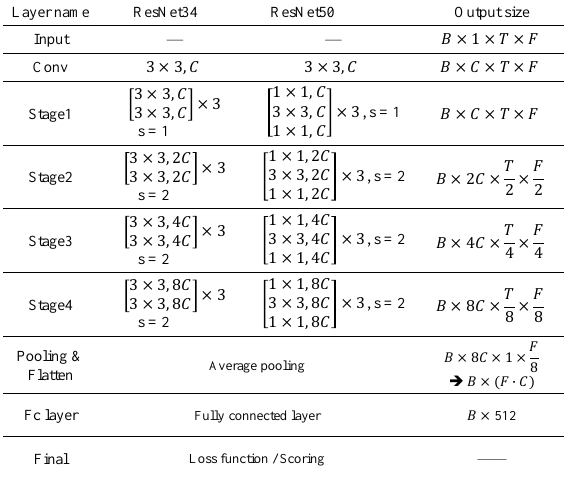
Figure 2. ResNet34 and ResNet50